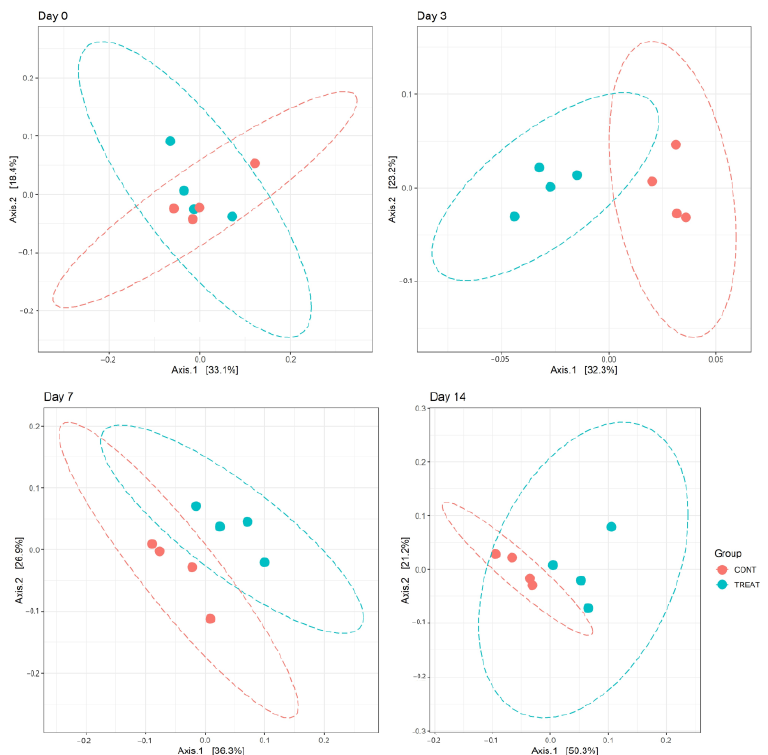
Figure 1. The microbial community alpha richness diversity (Chao and InvSimpson indexes) in cat- tle feces comparing control (CONT, red) versus antibiotic treatment (TREAT, blue) samples col- lected on 0, 3, 7, and 14 days.